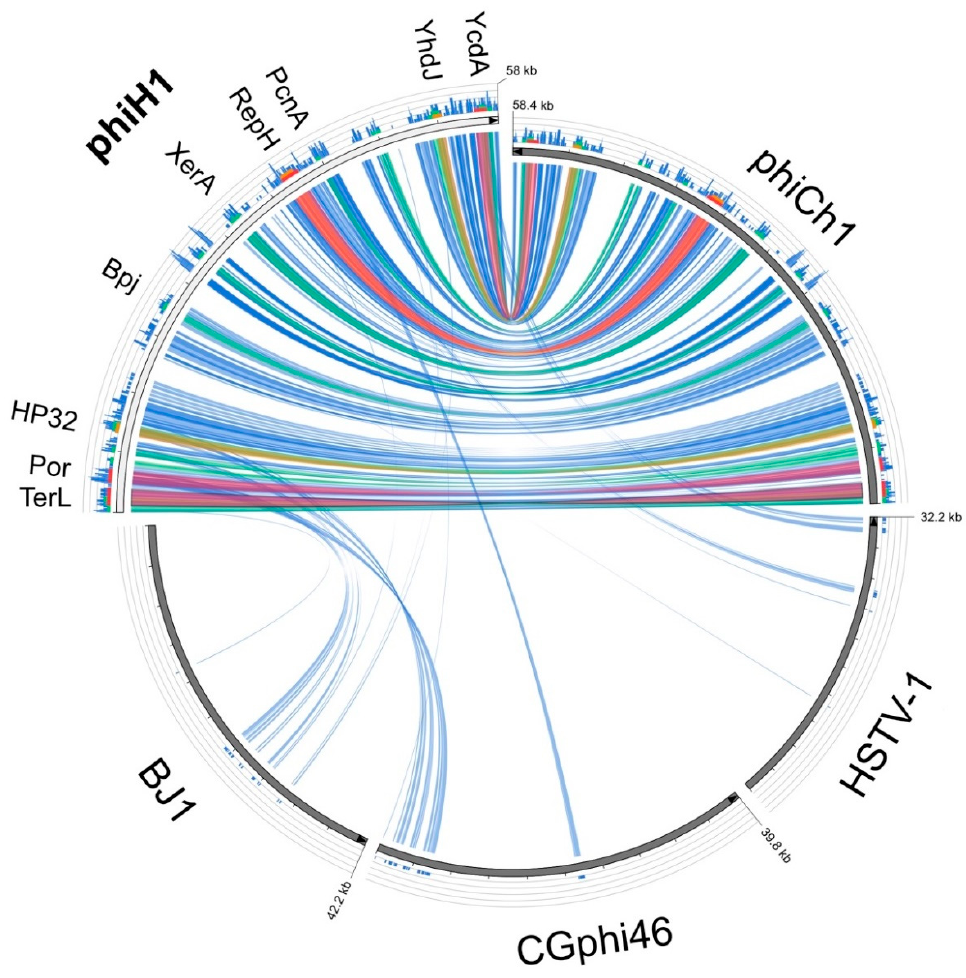
Figure 3. Circos plot of amino acid similarity (tBLASTx) between phiH1 and the haloviruses phiCh1, BJ1, CGphi46 and HSTV-1. The threshold for connecting lines was E-value ≤ 10 − 40 , with line colours reflecting the ratio of actual tBLASTx bitscore to the maximal score (using ‘score/max’ ratio colouring with blue ≤ 0.25, green ≤ 0.50, orange ≤ 0.75, red > 0.75). The outer histogram counts how many times each colour has hit the specific part of the sequence and uses an equivalent colouring scheme. The distance between successive tick marks shown along each virus genome represents 0.1 of the full genome length. Protein names shown along the phiH1 genome indicate the positions of the corresponding genes.